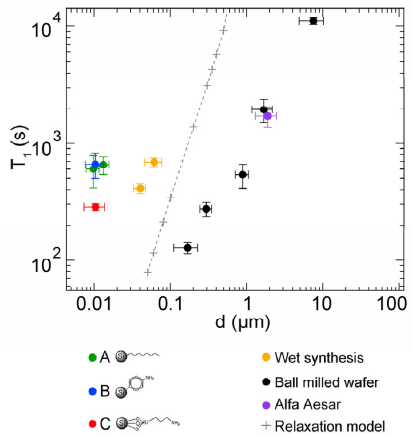
Figure 11. Nuclear spin relaxation ( T 1 ) times at 2.9 T and 300 K as a function of particle diameter d for Si NPs. Previously reported T 1 measurements of other Si particles are shown as a reference. Simulations of the nuclear relaxation based on a spin diffusion model are also shown. Vertical error bars are from exponential fits to relaxation data; horizontal error bars are from size distributions. (Reprinted with permission from Reference [26]. © 2013 American Chemical Society).